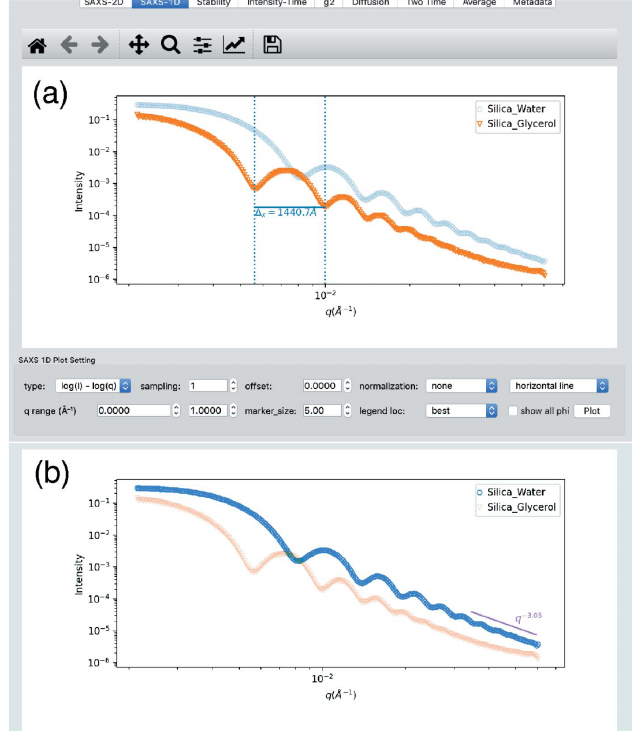
Figure 2 1-D small-angle scattering visualization. Users can draw horizontal lines (vertical dashed lines help users locate peaks/valleys) to estimate the structure size as shown in ( a ) or draw slopes to estimate the power-law decay constant as shown in ( b